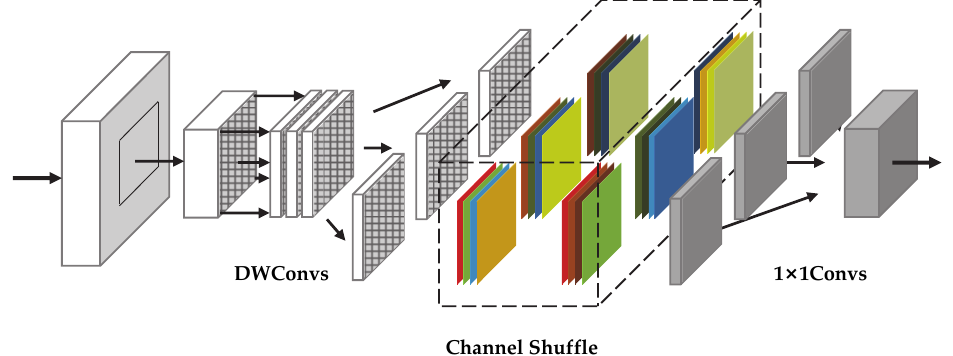
Figure 6. The workflow of Channel Shuffle. In the dashed boxes, the colored pictures on the left represent the feature maps of the different channels, while those on the right represent the reorganized feature maps. It should be noted that the number of channels varies from layer to layer and the color here only represents the feature maps of the different channels.